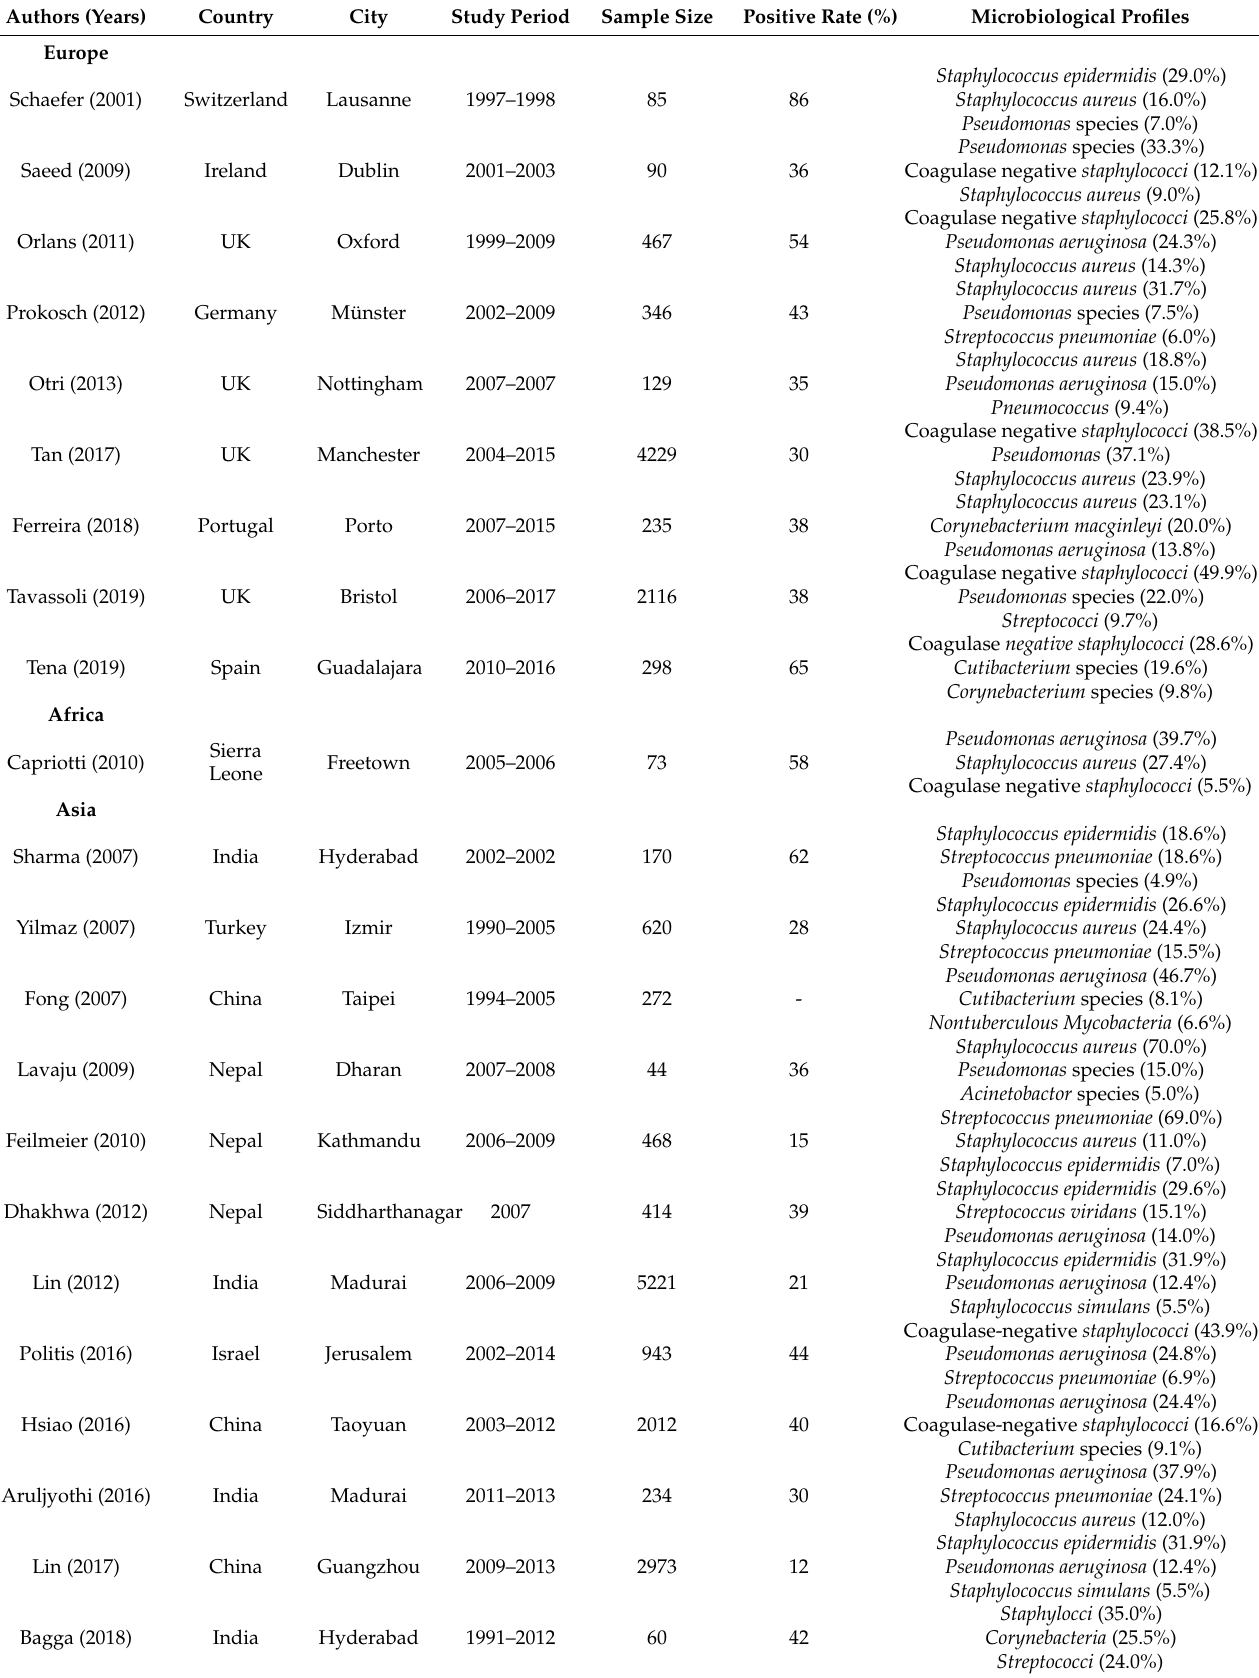
Table 1. Characteristics of the studies included in the